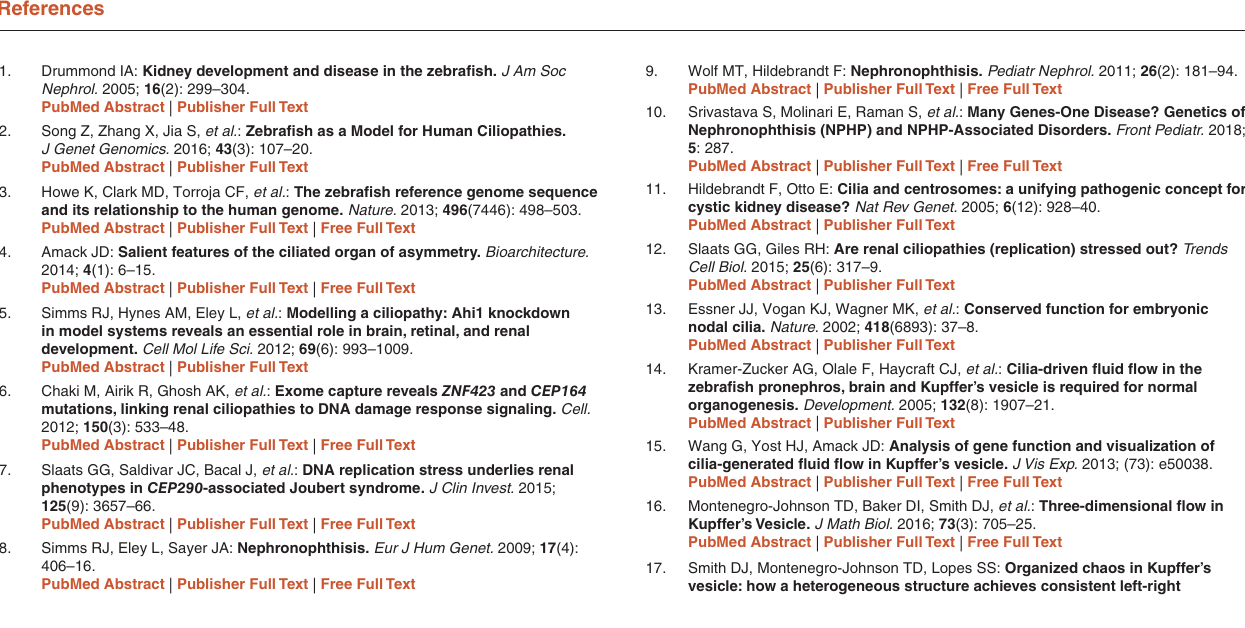
Dataset 1. Raw, uncropped images from which Figures 1-3 were generated. Leftmost image, Figure 1; middle six images, Figure 2; rightmost two images, Figure 3. DOI: 10.5256/ f1000research.15511.d210727 21